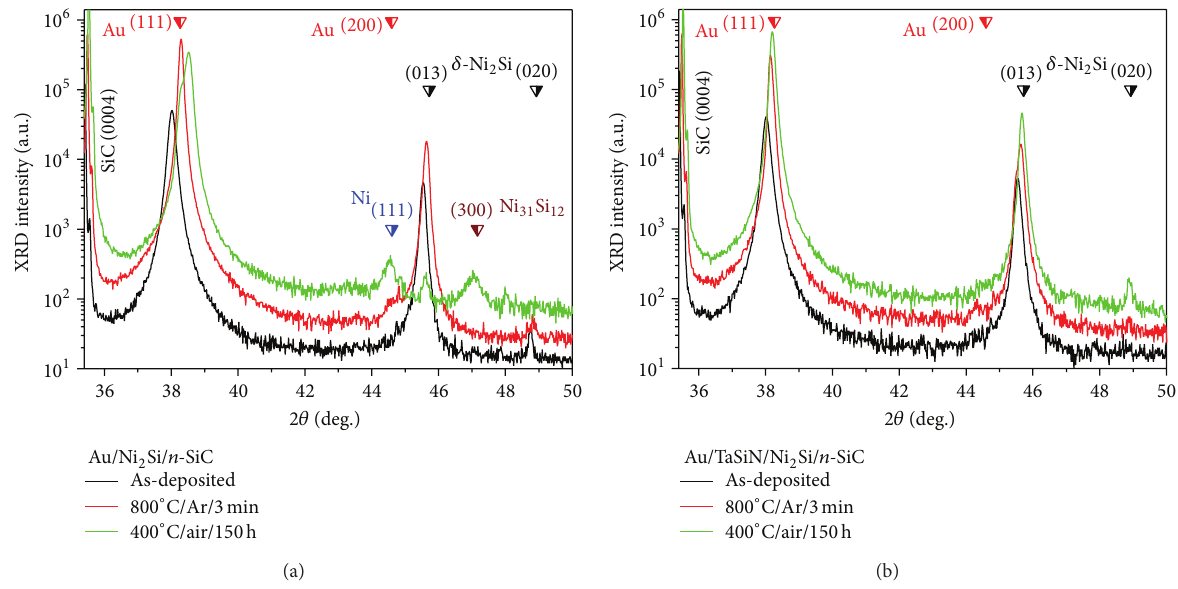
Figure 16: XRD spectra of the Au/Ni 2 Si/ n -SiC (a) and Au/Ta 35 Si 15 N 50 /Ni 2 Si/ n -SiC (b) ohmic contacts before and after heat treatments.